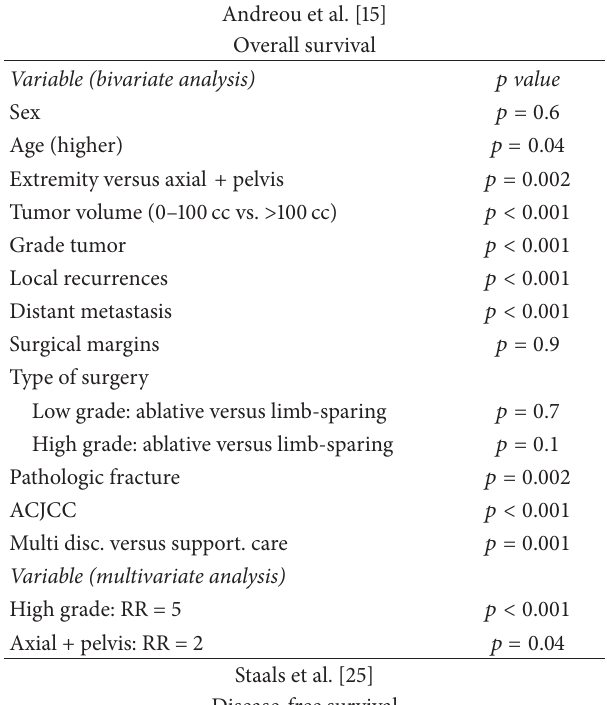
Table 7: Prognostic factors. Andreou et al.